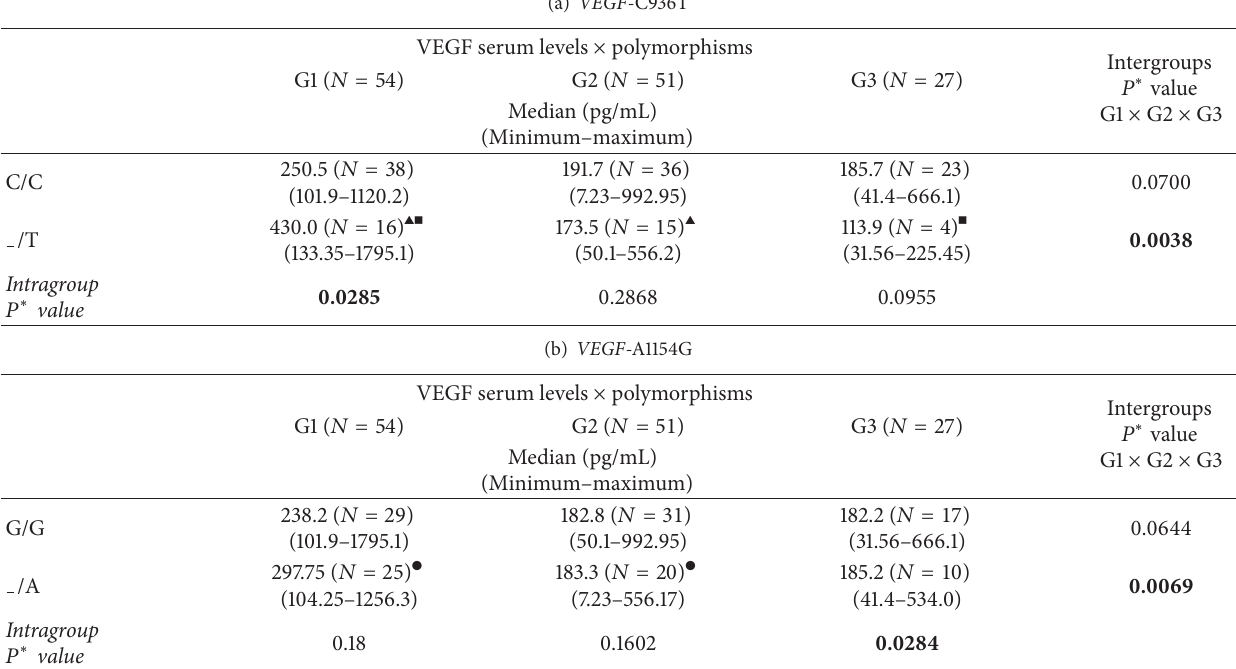
Table 4: Quantitative analysis of allelic and genotypic frequencies of VEGF -C936T and VEGF -A1154G polymorphisms in patients with hepatocellular carcinoma (G1), cirrhosis (G2), and controls (G3), considering serum levels of